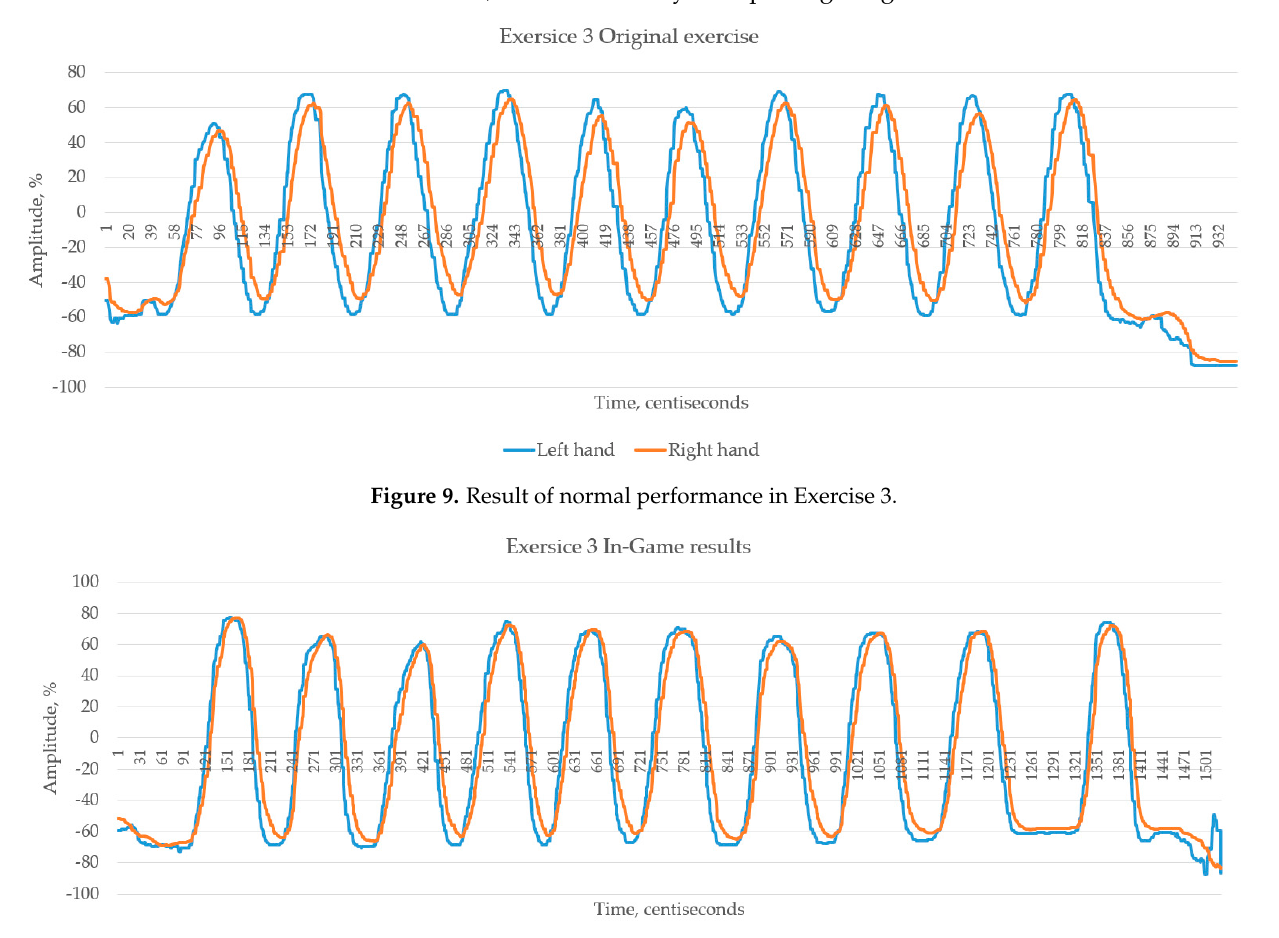
Figure 8. The result of incorrect performance of Exercise 3.